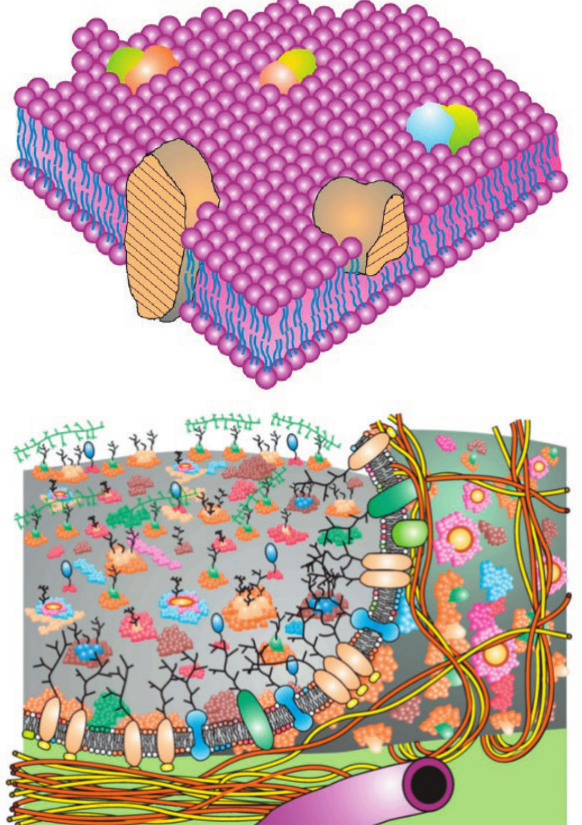
Figure 2. Top : Colorized version published by Nicolson (2014) 47 of the Singer and Nicolson (1972) 35 fluid-mosaic membrane model. Originally, it consisted of a phospholipid bilayer with interspersed proteins that could traverse the membrane. The hydrophilic phos- pholipid heads point to the external and cytoplasmic aqueous media, while the hydrophobic fatty acid tails point inward. Bot- tom : Nicolson (2014) 47 also provided an upgraded membrane model containing what modern-day scientists believe to be more realistic structural and functional features. The basic lipid bilayer architecture is preserved, but in this drawing the membrane has been peeled up (at the right) so that the viewer can appreciate sev- eral membrane-associated cytoskeletal (bottom left) and extracel- lular (top left) interactions. Integral proteins, glycoproteins, lipids, and oligosaccharides are represented by different colors. Protein and lipid domains are evident throughout the membrane. Science moves at a rapid pace in its attempt to unravel the functional attrib- utes of these and many other membrane